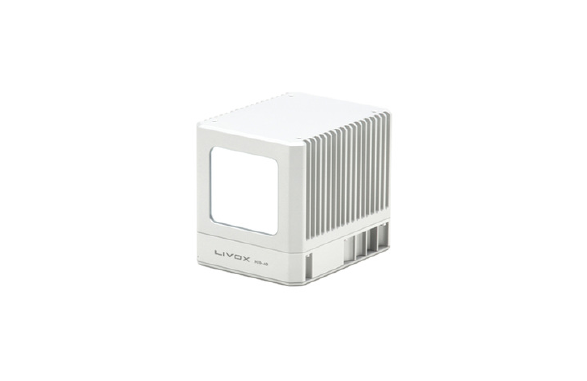
Figure 1. Livox MID-40 Sensor (Source: www.livoxtech.com)